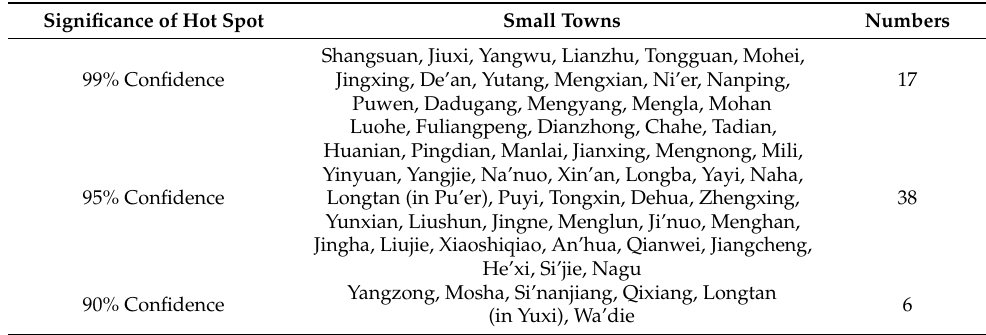
Table 6. Cluster results of transport location dimension (hot spot).